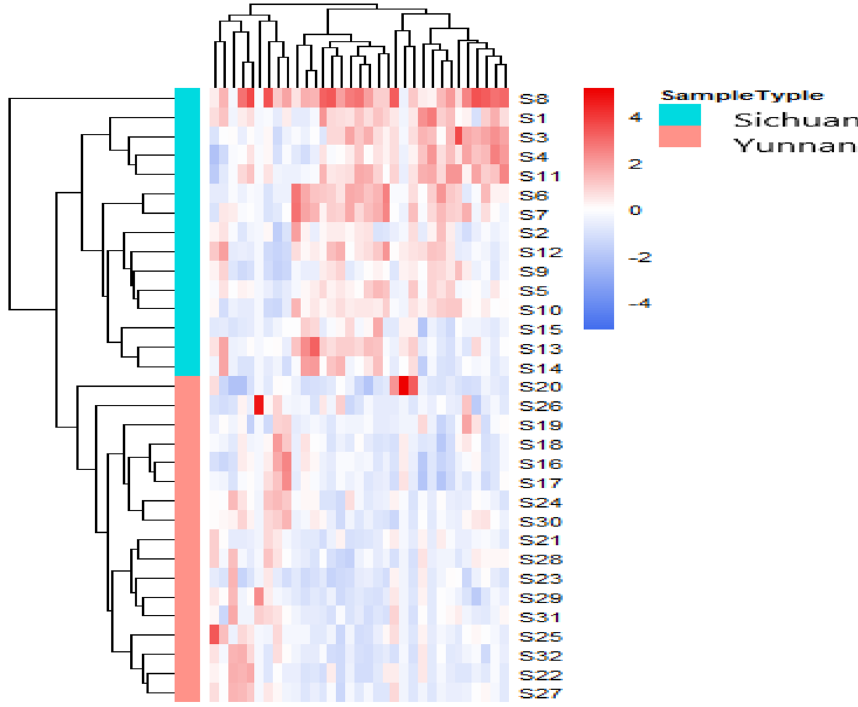
Figure 4. Hierarchical clustering analysis of 32 P. notoginseng samples from two producing